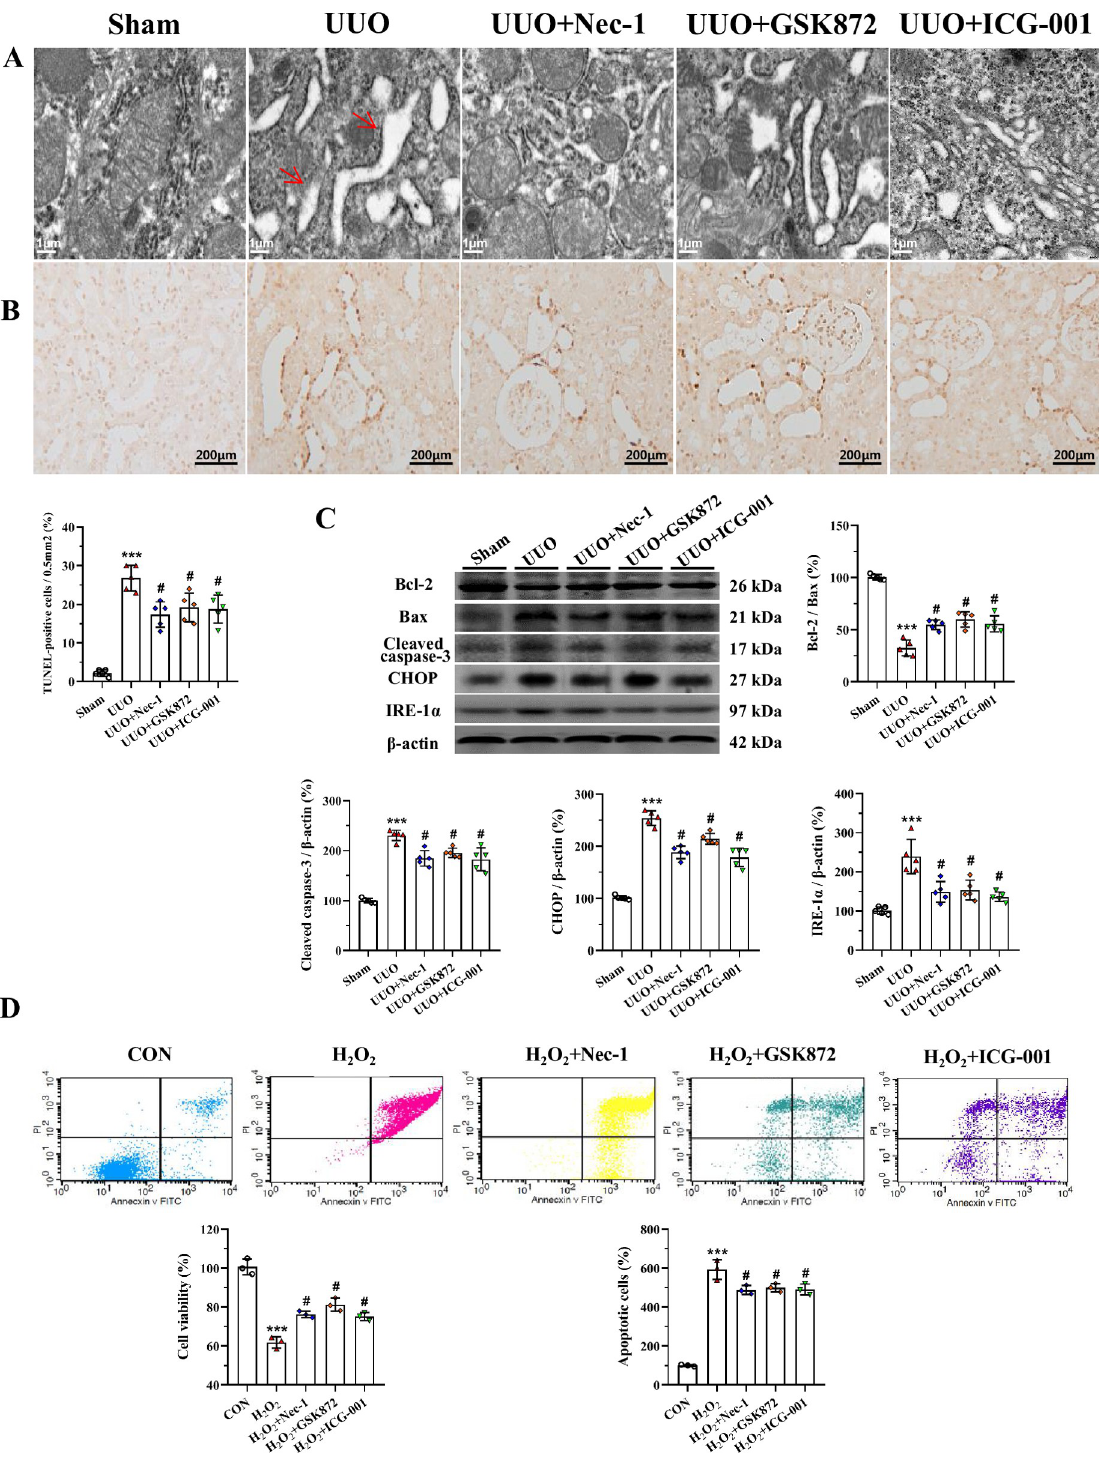
Fig 6. Representative photomicrographs of transmission electron microscopy (A), TUNEL assay (B), immunoblotting analysis (C), and cell viability and apoptotic cell death in HK-2 cells (D). ��� P < 0.01 vs. sham or control; # P < 0.05 vs. UUO or H 2 O 2 .